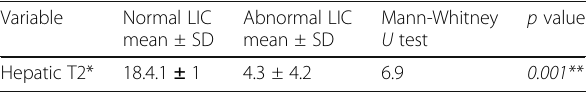
Table 5 Association between LIC and hepatic T2* in the studied group Variable